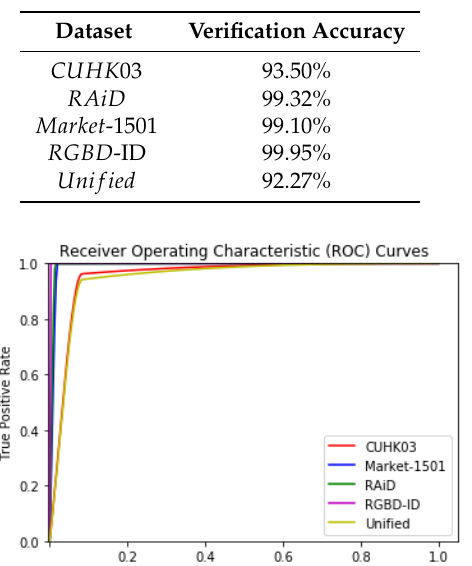
Table 6. Verification accuracy per dataset as achieved by the Siamese network.